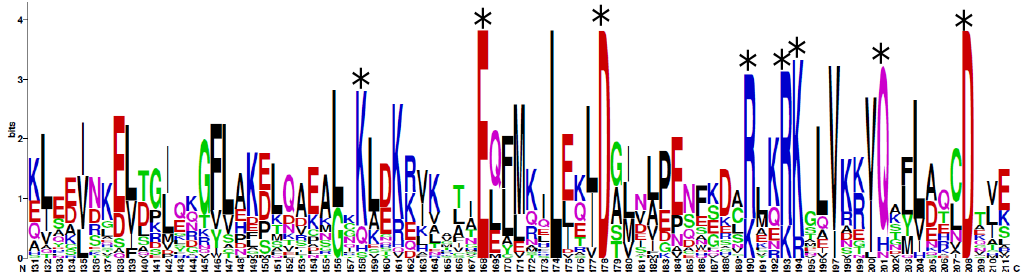
Figure 6. BAG-1 homologs share all the known Hsp70-interaction sites. Multiple sequence alignments were generated for BAG-1 homologs using MAFFT version 7. MAFFT outputs were then aligned to the human BAG1 and manually edited using BioEdit, to remove any gaps present within the BAG domain. Sequence logos were then generated for a particular region, including the BAG domain using the WebLogo server [38]. Positions marked with a black asterisk represent highly conserved amino acids required for Hsp70 interaction [25]. Sequence logos were generated using sequences from 129 animals, 32 plants, and 5 fungi species.